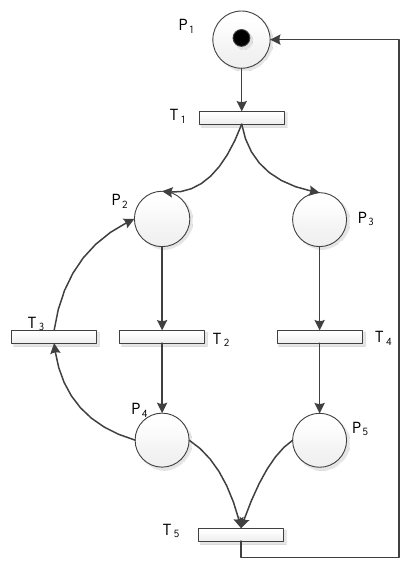
Figure 4. A simple sample of the Stochastic Petri Nets (SPN) model.